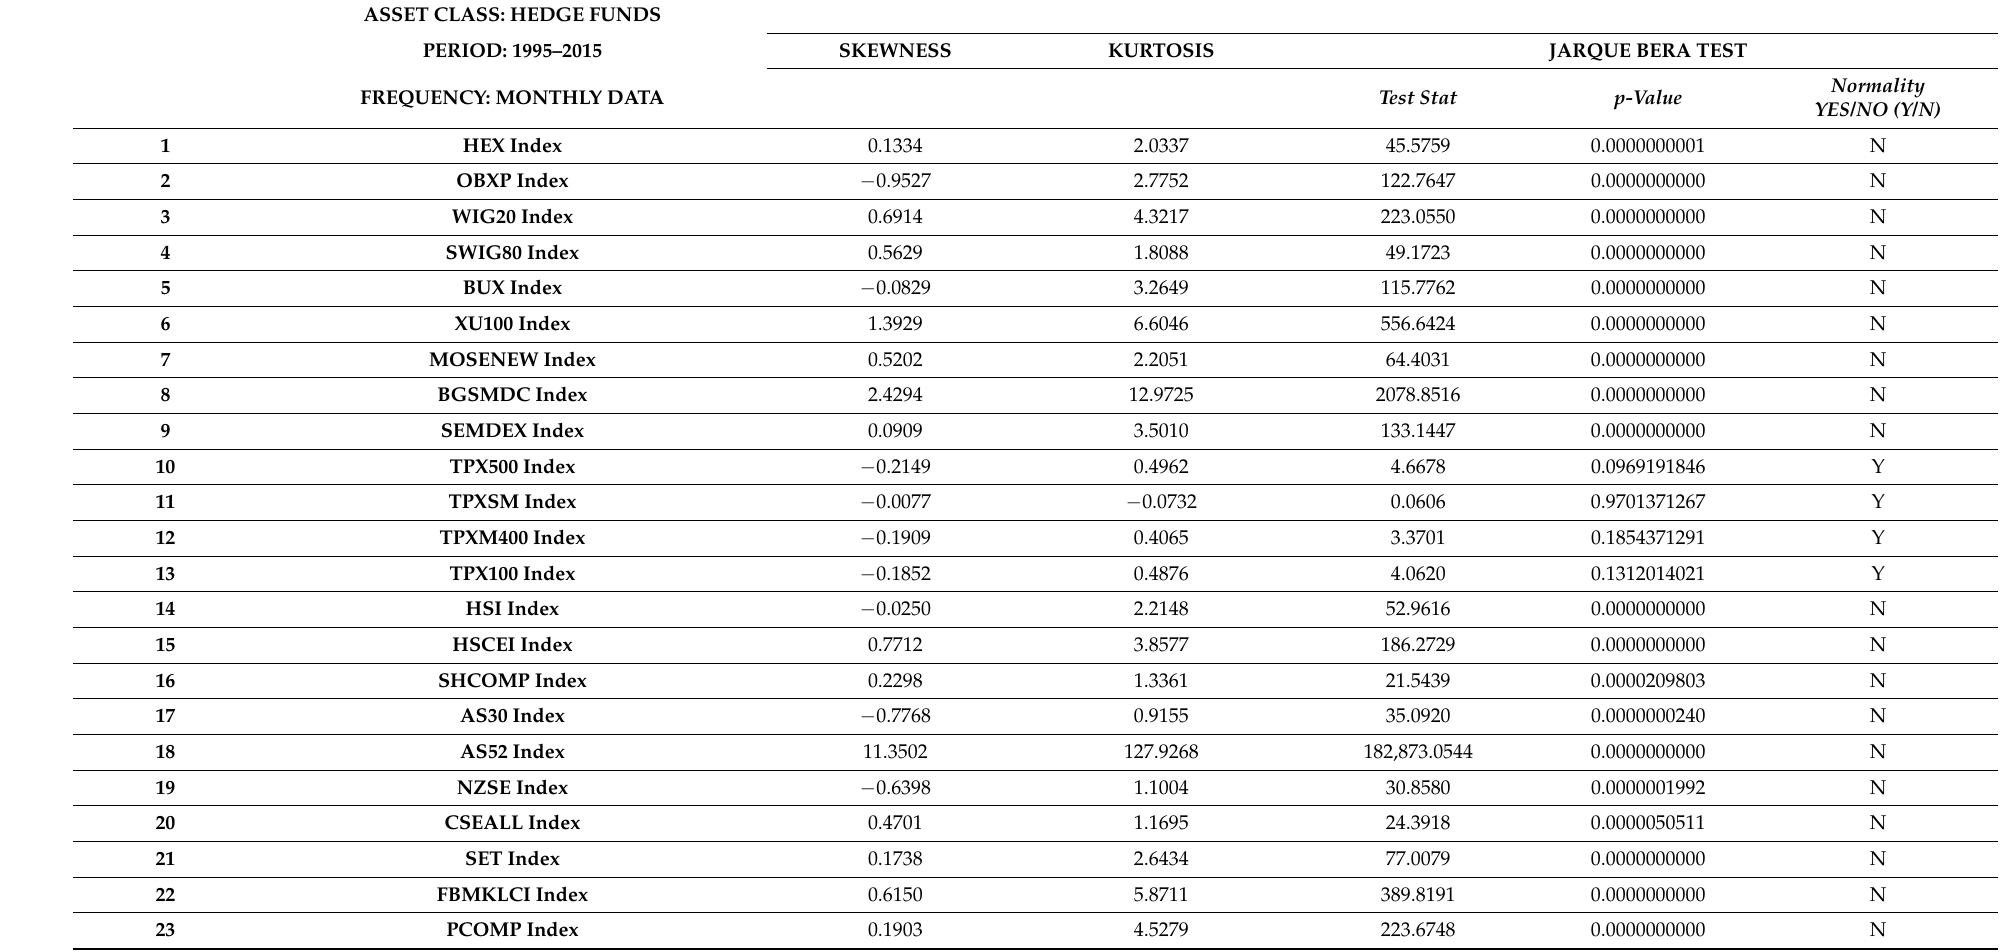
Table A2. Jarque Bera Test On Global Equity Indices Data